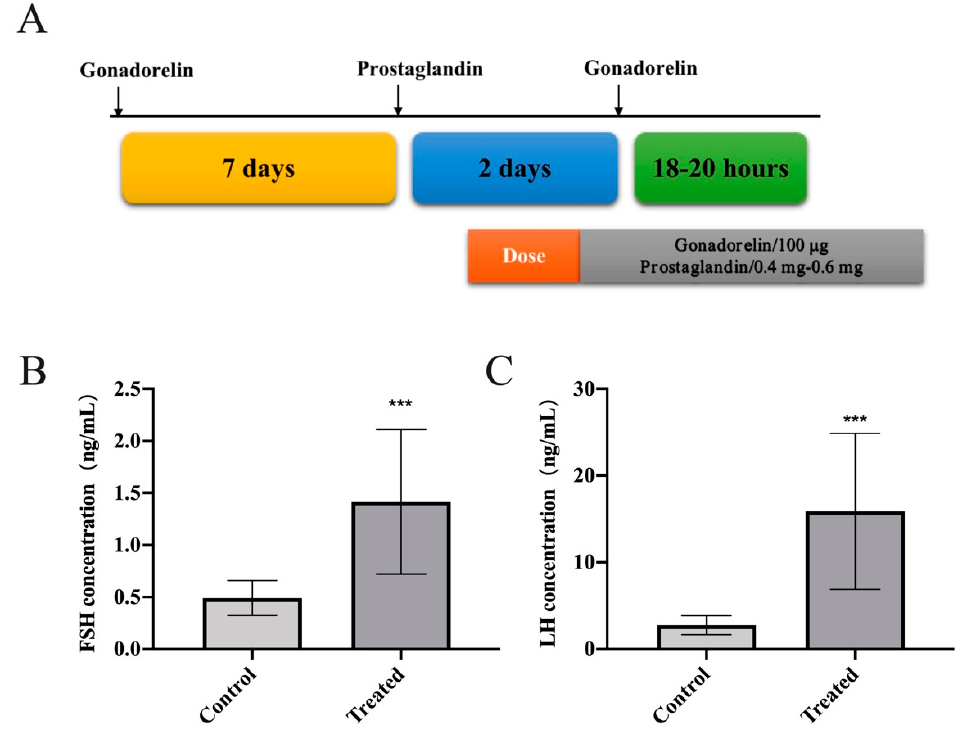
Figure 1. GnRH analogue treatment promoted the synthesis and secretion of FSH and LH in cows. ( A ) The combined treatment program diagram of gonadorelin and prostaglandin for cows. ( B , C ) ELISA was used to determine the FSH and LH secretion of cows after treatment. All experiments were repeated at least three times. Data are presented as the means ± SD. p < 0.05 was considered significant, and the differences are marked with the symbol *. When p < 0.001, *** was used to show the significance of the difference.